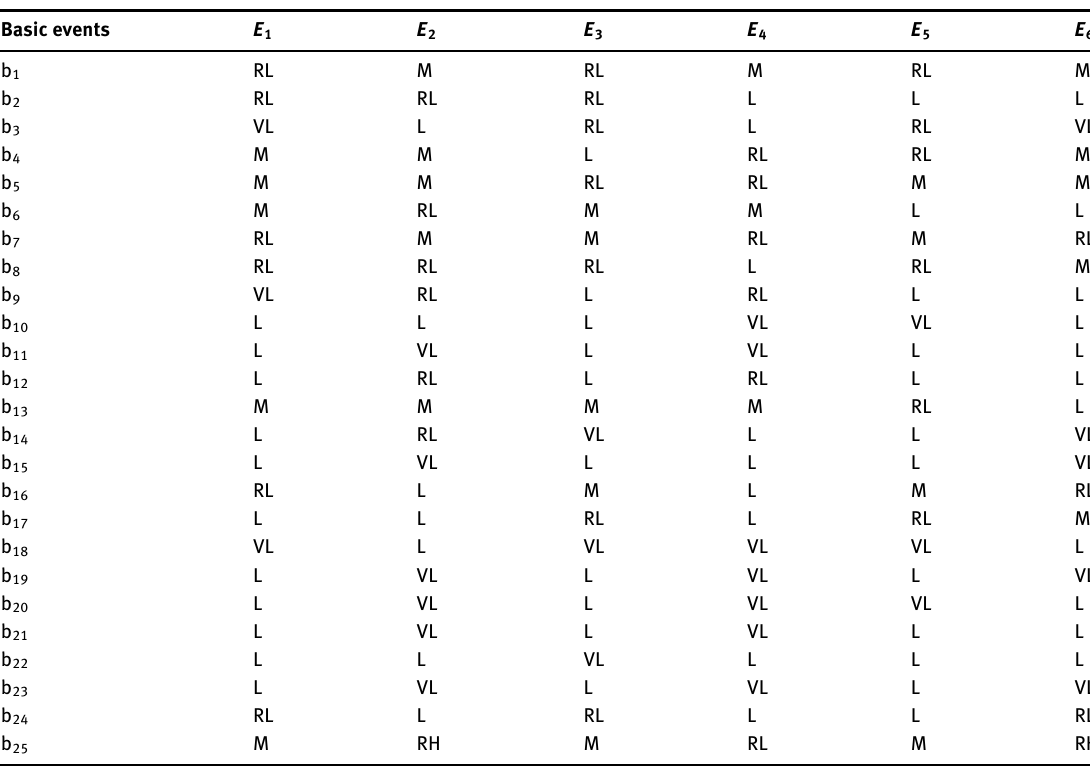
Table 6: Expert Opinions on the Basic Events of the CERPS Group 1 Fault Tree [36, 37].